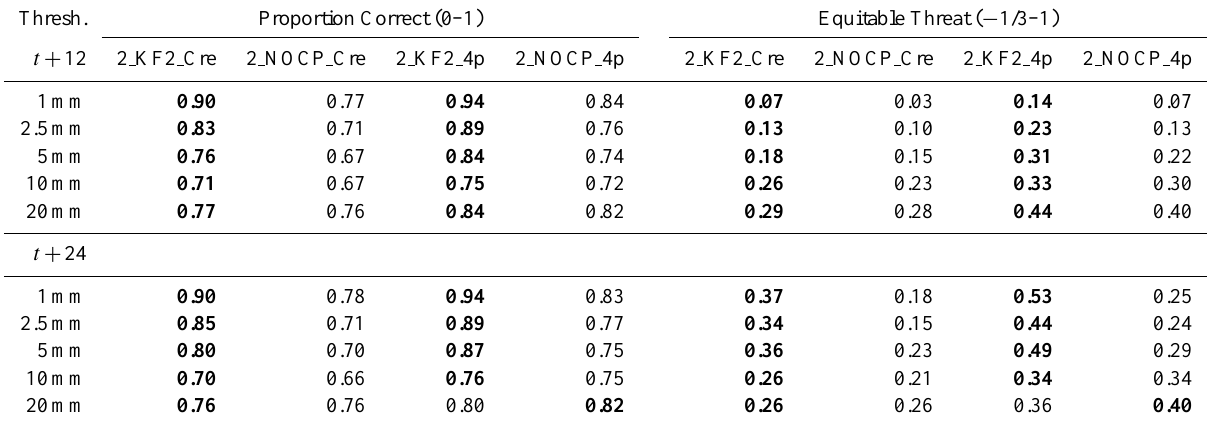
Table 4. As for Table 3 but for Epirus only with and without activation of the Kain-Fritsch-2 CPS in the 2km grid. For each categorical statistic and for each method the best values are presented in bold. Thresh. Proportion Correct